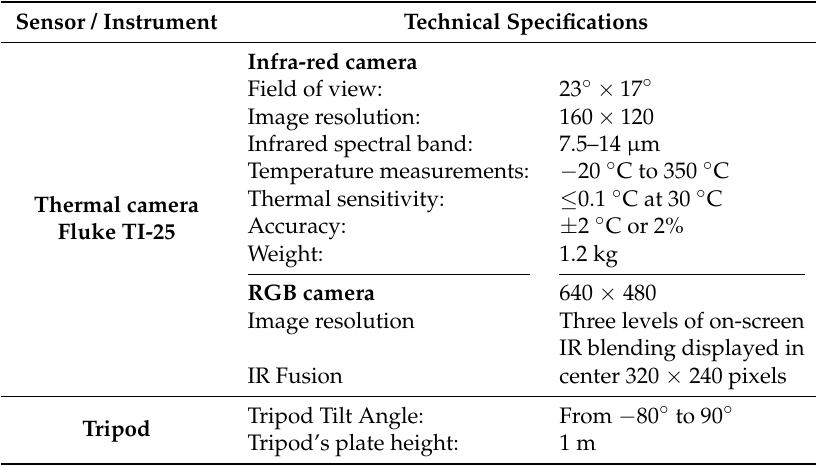
Table 2. Technical specifications of sensors and instruments used in this